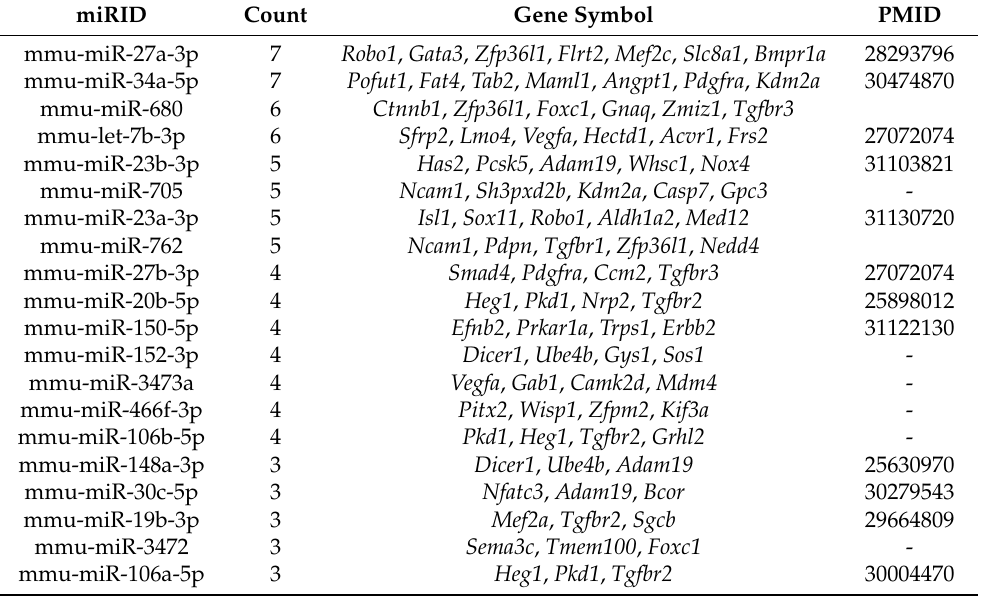
Table 1. Top 20 miRNAs targeting heart related genes both in vivo and in vitro. Some of the miRNA– mRNA interactions have been already experimentally tested but have not been associated with heart related processes. PMID column indicates the publication where an association has been already